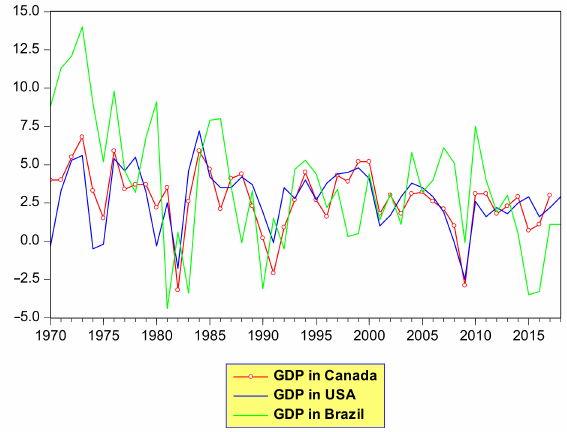
Figure 1. The evolution of GDP for USA, Canada and